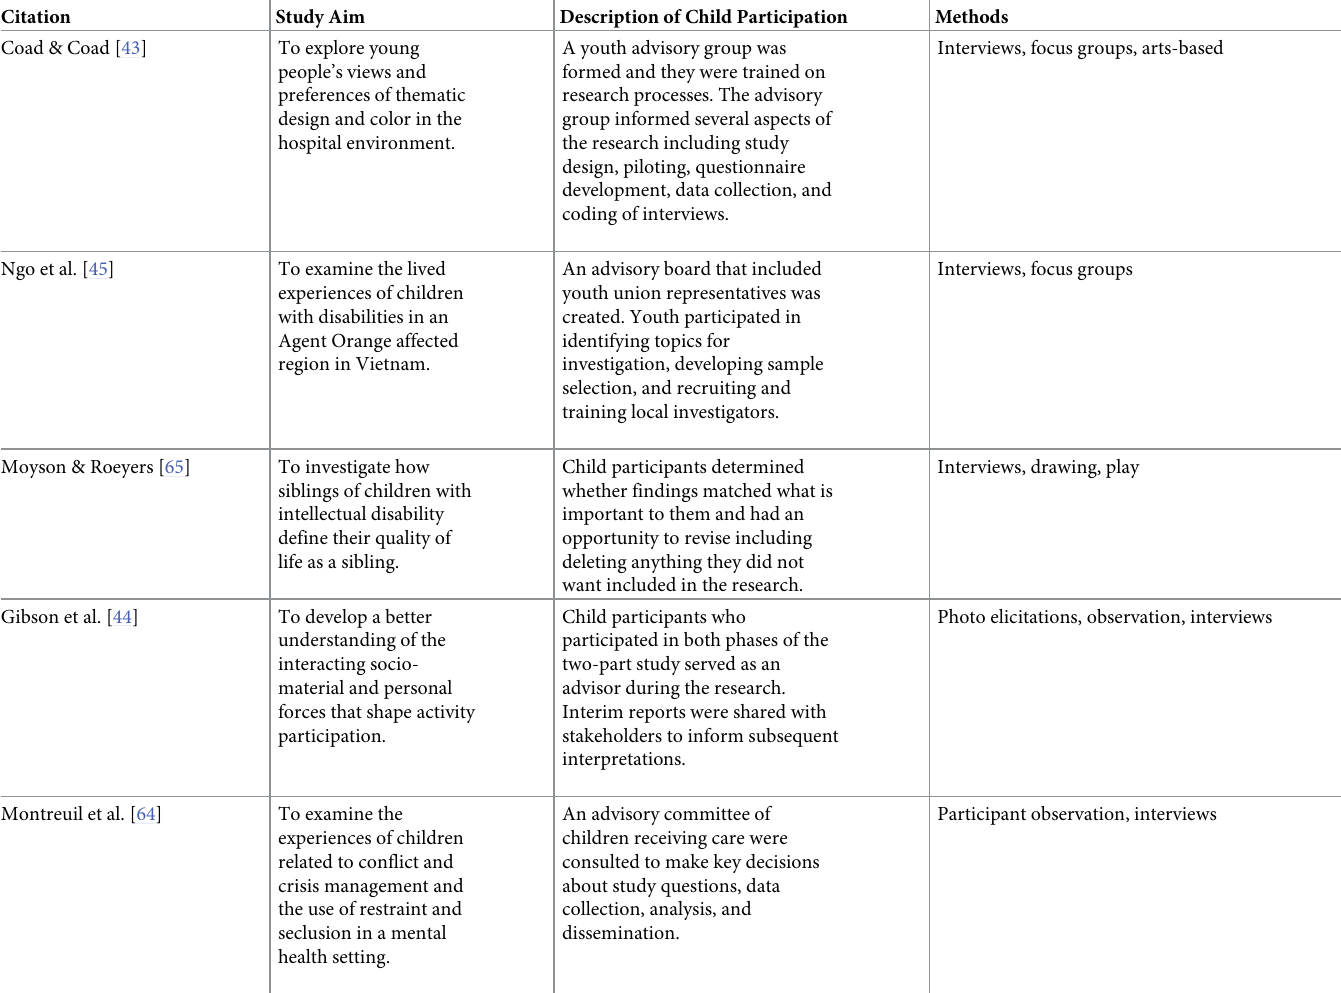
Table 2. Articles demonstrating research by